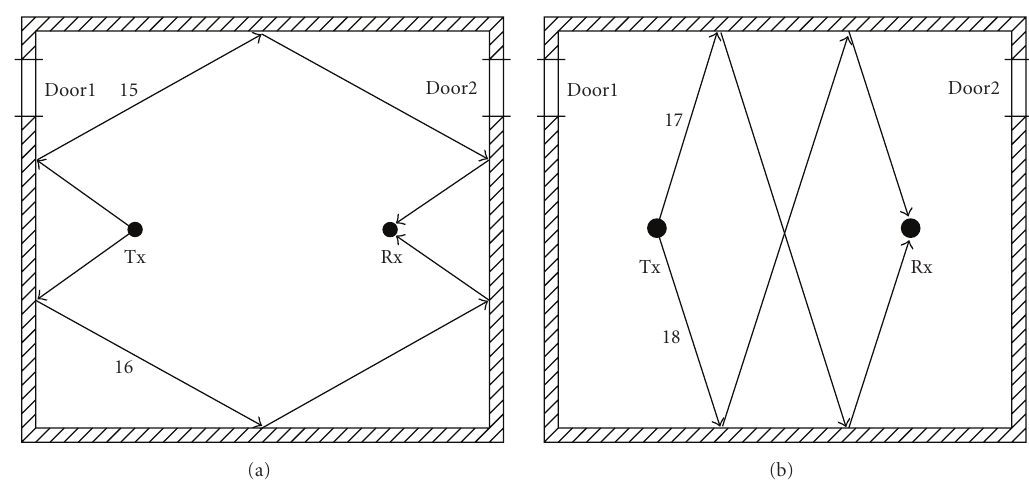
Figure 17: Illustration of paths (a) 15 and 16 (b) 17 and